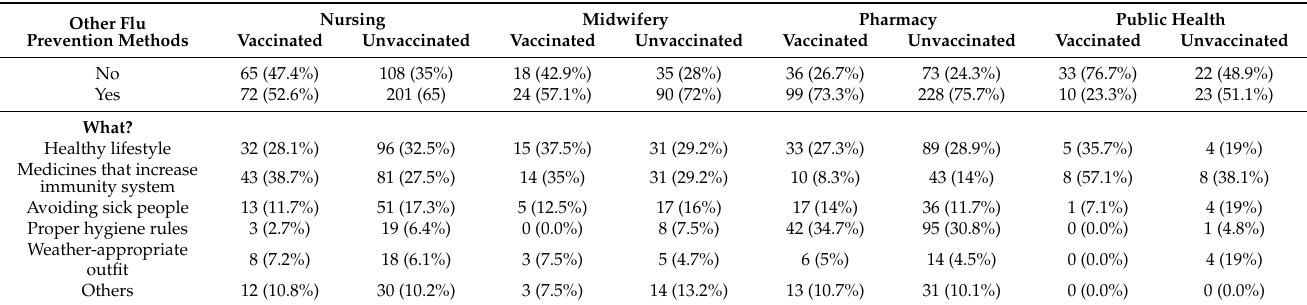
Table 7. Other methods for preventing flu reported by students, according to major and vaccination status. Other Flu Prevention